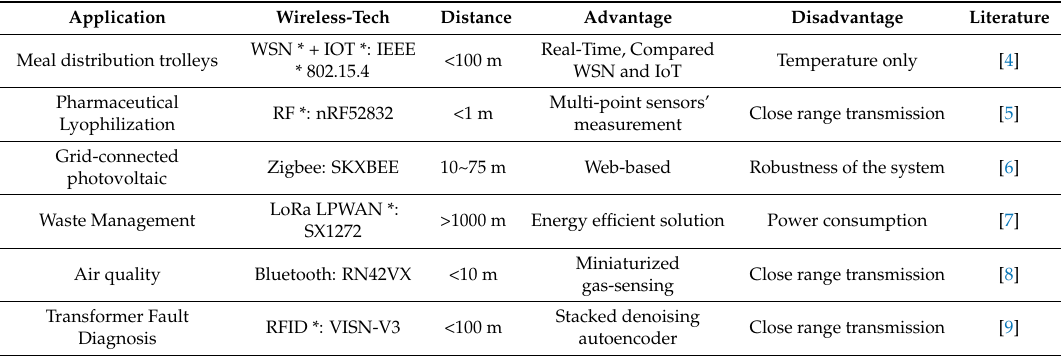
Table 1. Comparison of main wireless-technology and applications about monitoring